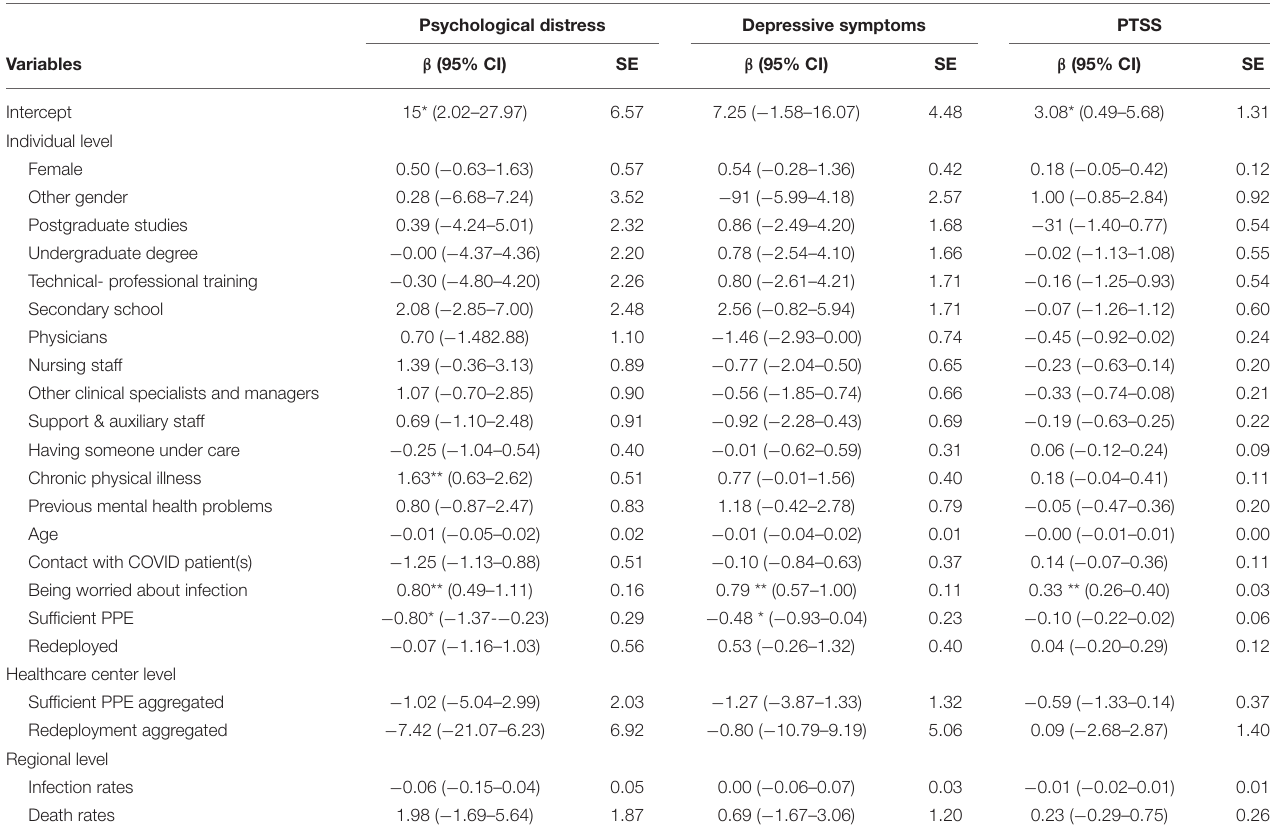
TABLE 4 | Three-level multilevel models for psychological distress, depressive symptoms and